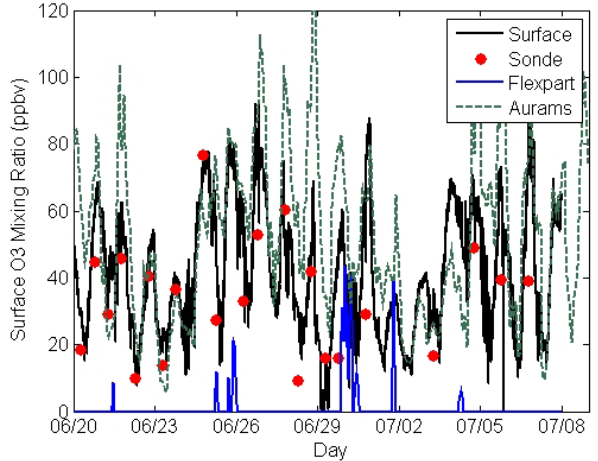
Fig. 11. Comparison of surface ozone mixing ratios (ppbv) at Harrow from observations and model simulations at ground level: surface ozone measurements (black line), ozonesonde observations at ground level (red dots), bias-corrected GEM-FLEXPART ozone mixing ratio at 190m a.s.l. (blue line), and GEM-AURAMS ozone mixing ratio at 190m a.s.l (green dashed